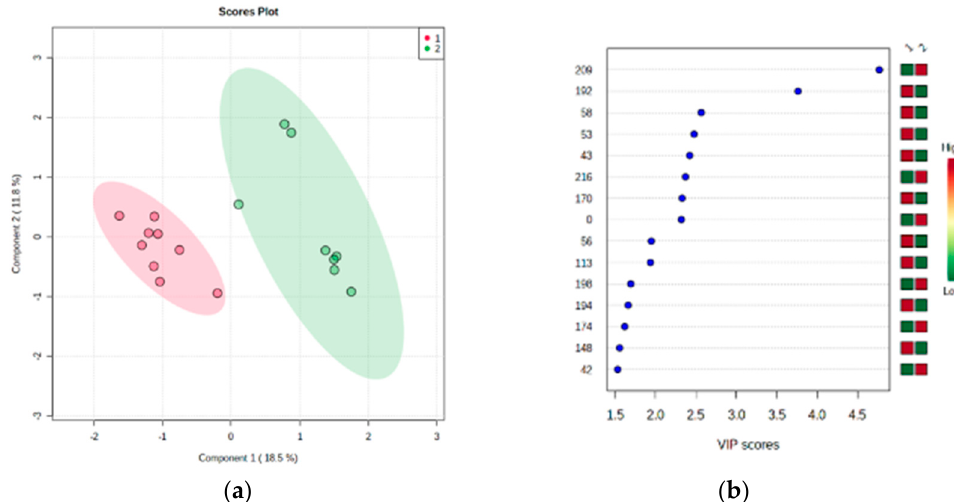
Figure 2. ( a ) Two-dimensional representation of components from Partial Least Square – Discriminant Analysis (PLS-DA), showing clear separation between healthy (1) and burning mouth syndrome (2) groups. ( b ) VIP (Variable Importance in Projection) describing the spots contributing most to group separation.